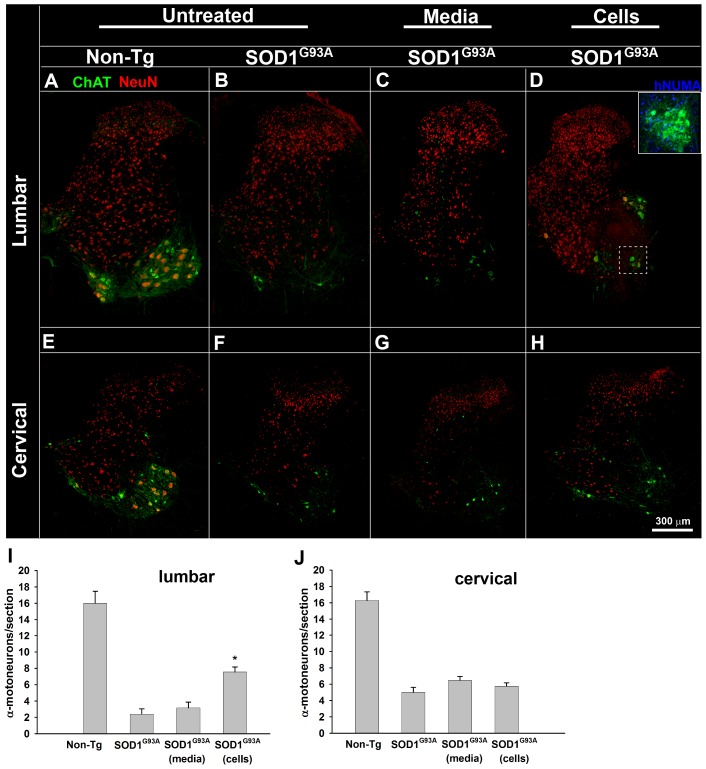
SOD1G93A rats receiving lumbar grafts of human spinal neural stem cells show higher α-motoneuron survival at the lumbar but not cervical spinal segments.Lumbar transverse spinal cord sections from untreated, non-transgenic (Non-Tg; A) and untreated SOD1G93A transgenic (SOD1G93A; B) animals, as well as SOD1G93A animals treated with media (SOD1G93A media; C) or human spinal neural stem cell grafts (SOD1G93A cells, D) were double immunostained to identify all mature neurons (NeuN) and cholinergic cells (α-motoneurons, ChAT). While a dramatic reduction in ChAT-IR cells was noted in all SOD1G93A animals, regardless of treatment, quantitative analysis (I) of persisting α-motoneurons showed a significant increase in the α-motoneuron pool in the cell-grafted animals (D, I). Using adjacent histological sections, inset (D) shows an example of a group of transplanted cells (positive for human nuclear matrix antigen; hNUMA) near a pool of surviving α-motoneurons. Sections taken from the same animals but from the cervical level (C5/6) also show a dramatic reduction in the motoneuron pool but with no apparent protective effect afforded by the lumbar cell grafts (E–H, J). Scale bar: 300 µm. * P<0.001 compared to non-transgenic, P = 0.03 compared to the media-treated group; one-way ANOVA.